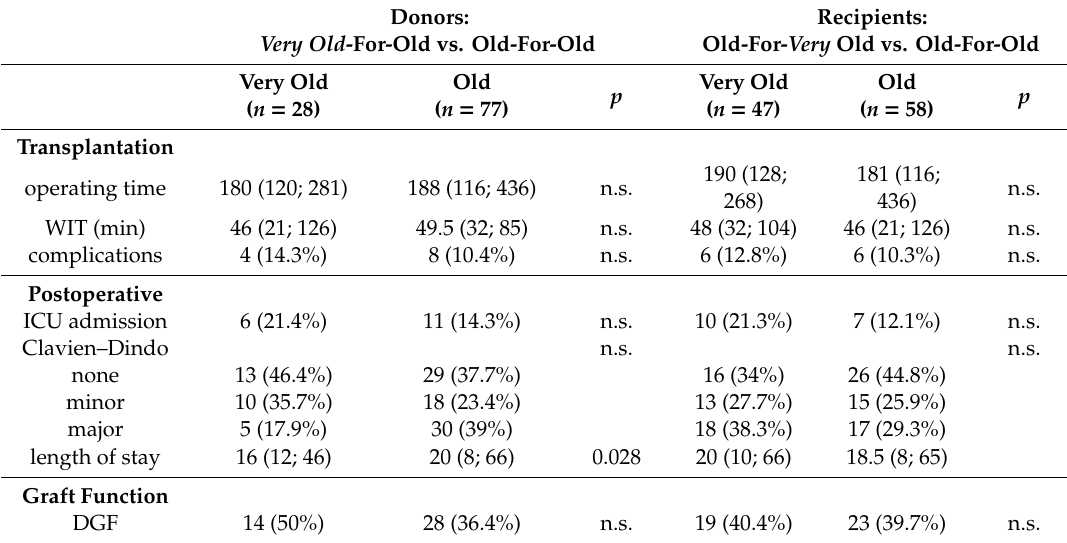
Table 3. Age-dependent comparison stratifying for donor age (very old donors ≥ 75 years vs. old donors) or recipient age (very old recipients ≥ 70 years vs. old recipients).